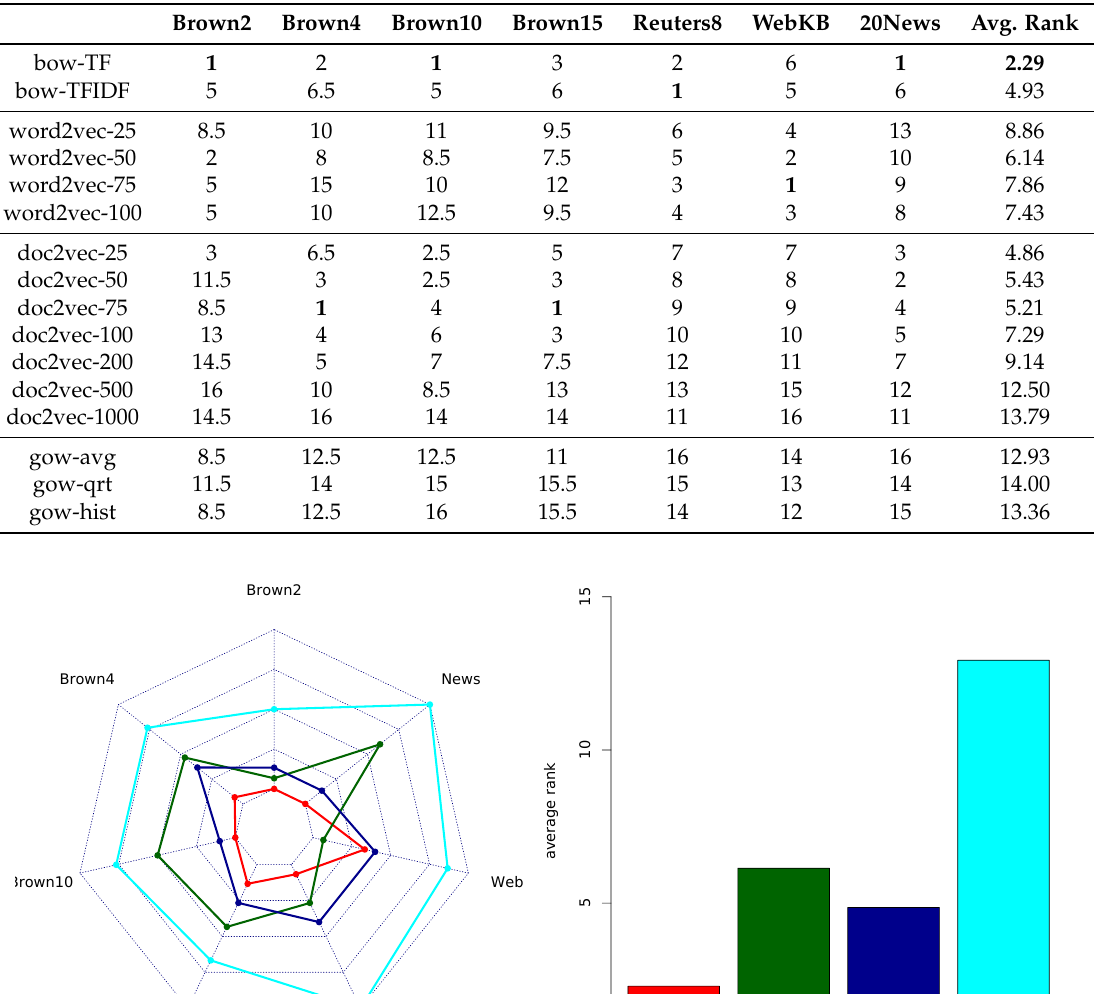
Table 6. Ranking of the 16 variants of the three document representation models by the document classification task with respect to classification accuracy. The last column reports the average rankings over the seven tasks. The top-ranked models in each column are shown in bold.